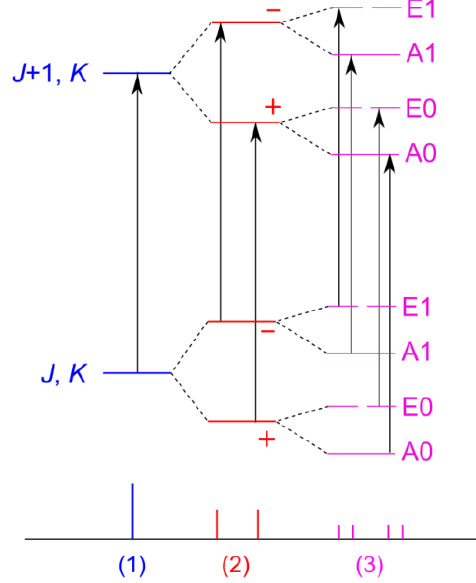
Figure 1. Non-scaled energy levels and microwave signal splittings for different types of molecules. (1) Asymmetric rigid rotor (e.g., phenetole [16]), (2) One two-fold tunneling motion (e.g., phenyl formate with the tunneling of the phenyl ring [25]), (3) One two-fold tunneling motion and a methyl internal rotation (e.g., phenyl acetate with the tunneling of the phenyl ring and the internal rotation of the acetyl methyl group, this work). Rotational a -type transitions are indicated as black arrows. Please note that, for sake of simplicity, the symmetric top J , K label is used to indicate the rotational levels, rather than the correct J , K a , K c one.